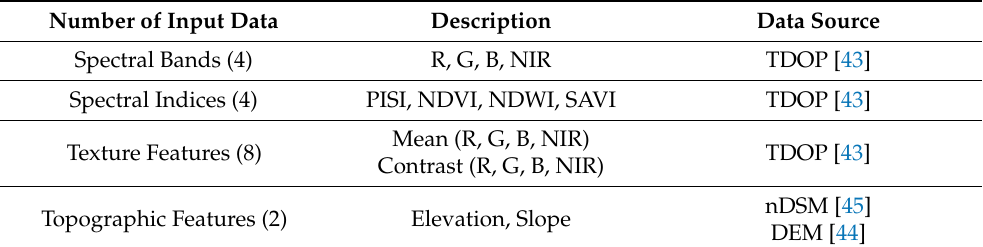
Table 3. List of input features used for the RF classifier in conjunction with the corresponding data sources utilized for this